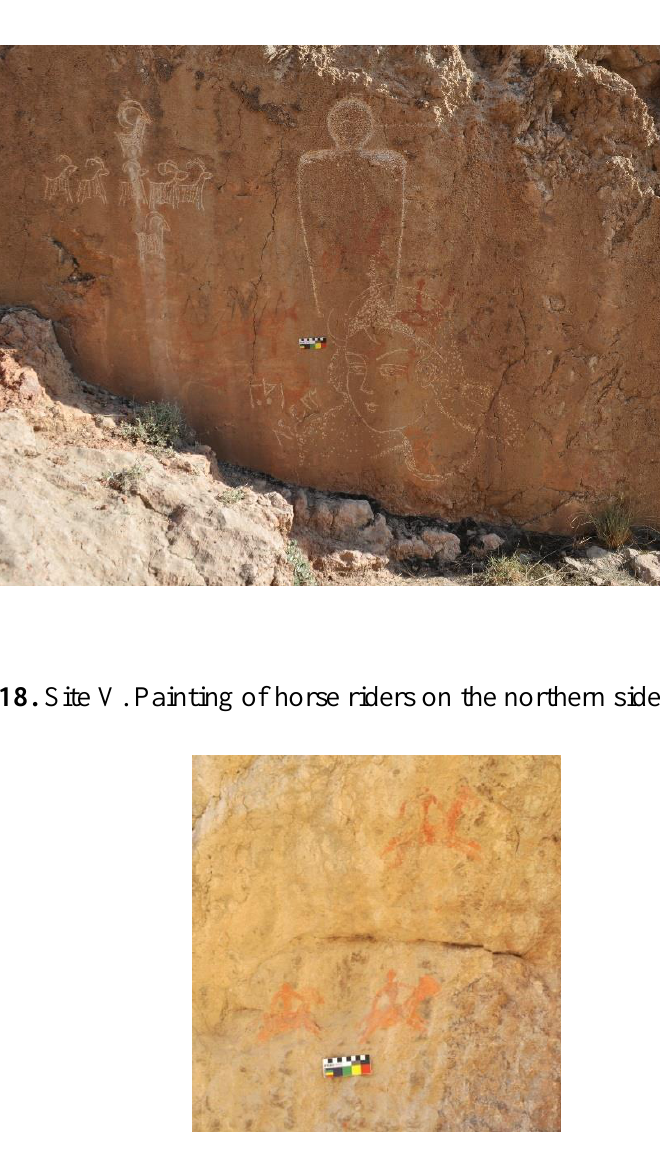
Figure 17. Site V. Recent engravings superimposed over the ancient pictograms on the southern rim of the channel.